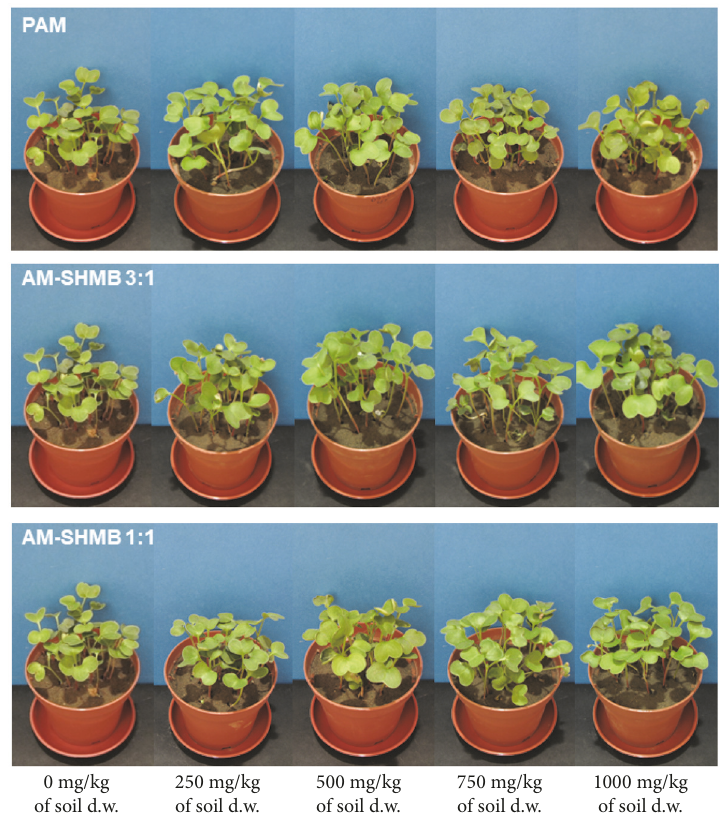
Figure 6: Digital photographs of radish seedlings growing for 14 days in soil amended with PAM and Tulipalin A-based hydrogels.